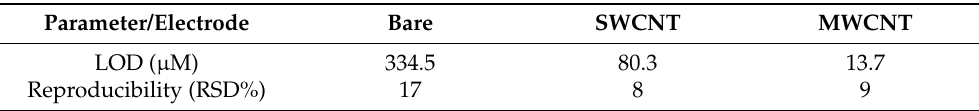
Figure 6. CV voltammograms obtained with different platforms (SWCNTs, MWCNTs, and bare SPEs), referred to: ( a ) the same concentration of HQ (5 mM), and ( b , c ) several HQ concentrations (from 0.1 µ M to 1 mM). Table 1. Limit of detection (lod) and reproducibility (rds%) for cv determination of hq in water, with different platforms.